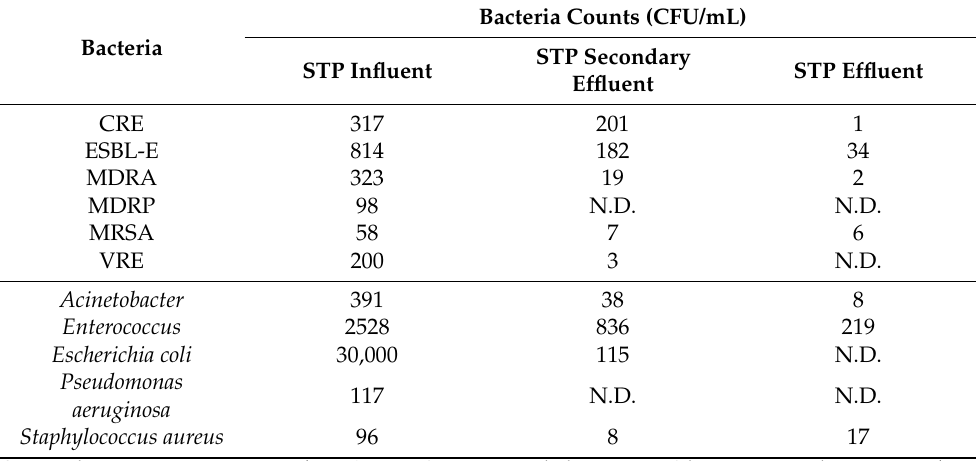
Table 1. Occurrence of AMRB and AMSB in sewage treatment plant (STP) influent, STP secondary effluent, and STP